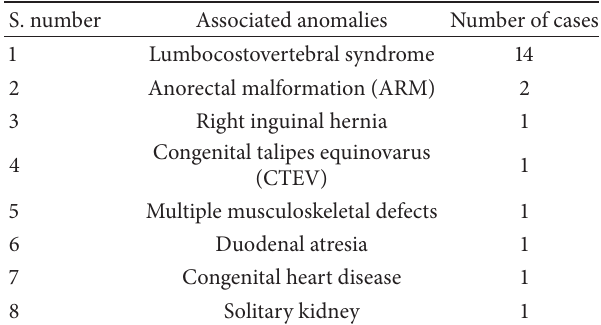
Table 2: Associated